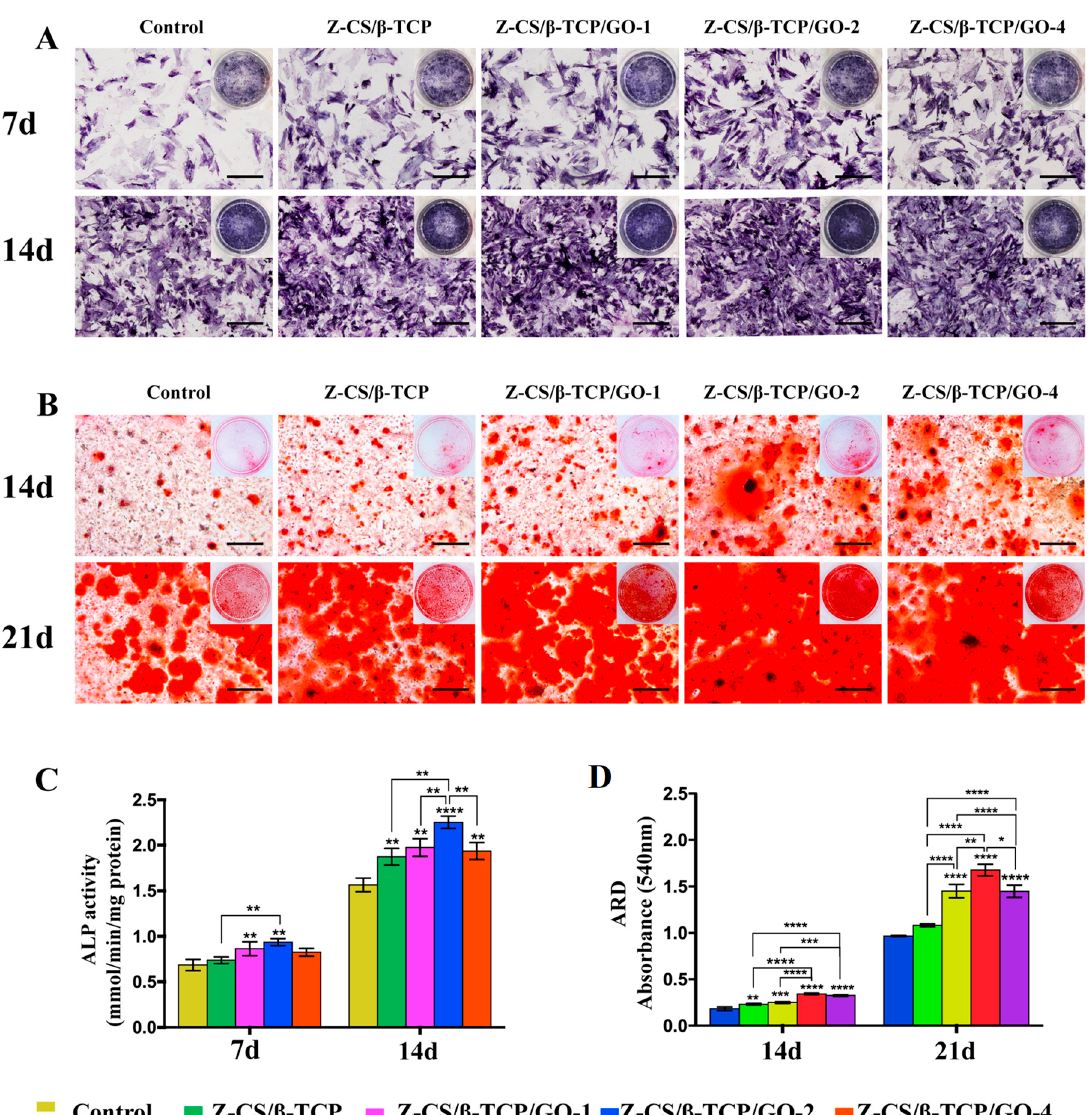
Figure 4. rBMSc osteogenic activity of rBMSc with different scaffolds. ( A ) ALP straining staining of rBMSCs cultured with different scaffolds for seven and fourteen days, scale bars, 200 μ m. ( B ) Alizarin red S stained cultured with different scaffolds for 14 and 21 days, scale bars, 200 μ m. ( C ) ALP activity. ( D ) Calcium nodules (* p < 0.05, ** p < 0.01, *** p < 0.001, and **** p < 0.0001).